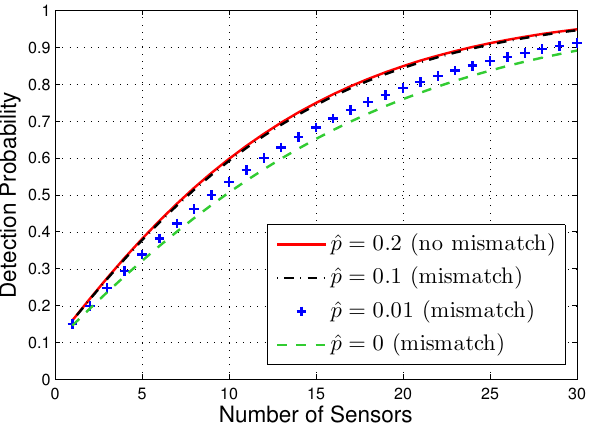
Figure 5. Performance of the proposed one-bit GLRT with several estimated values ˆ p of the crossover probability ˜ p = 0 . 2